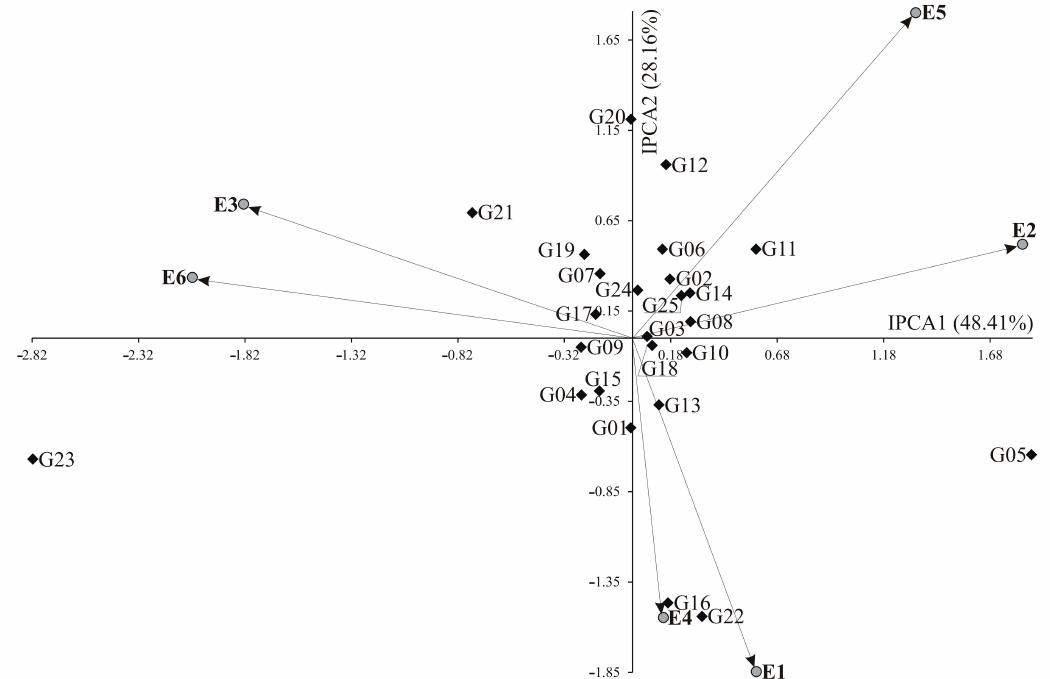
Figure 6. Biplot for genotype by environment interaction of total GLSs content in 25 winter oilseed rape ( B. napus ) genotypes in six environments, showing the effects of primary and secondary components (IPCA 1 and IPCA 2, respectively) (E1—Borowo, 2015; E2—Borowo, 2016; E3—Borowo, 2017; E4— Ł agiewniki, 2015; E5— Ł agiewniki, 2016; E6— Ł agiewniki, 2017).